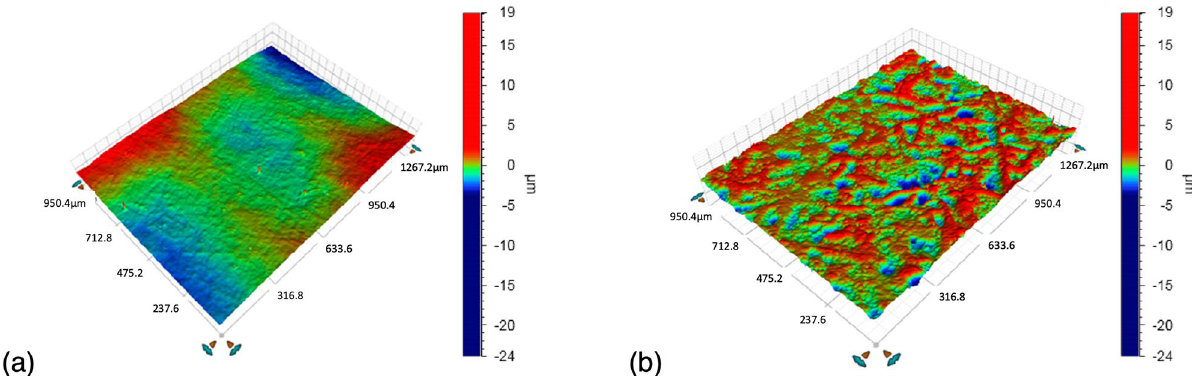
Figure 6. The profilometry surface images: ( a ) PET and ( b )